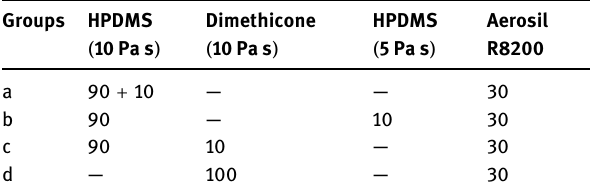
Table 3: RTV compositions using di ff erent base polymer